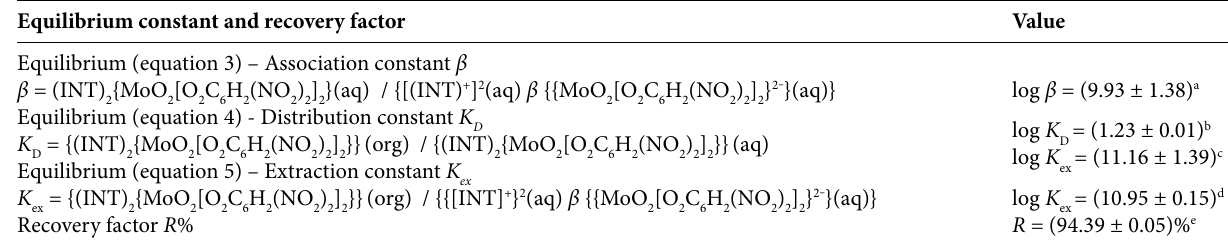
Table 3. Values of the equilibrium constants and the recovery factor Equilibrium constant and recovery factor Value